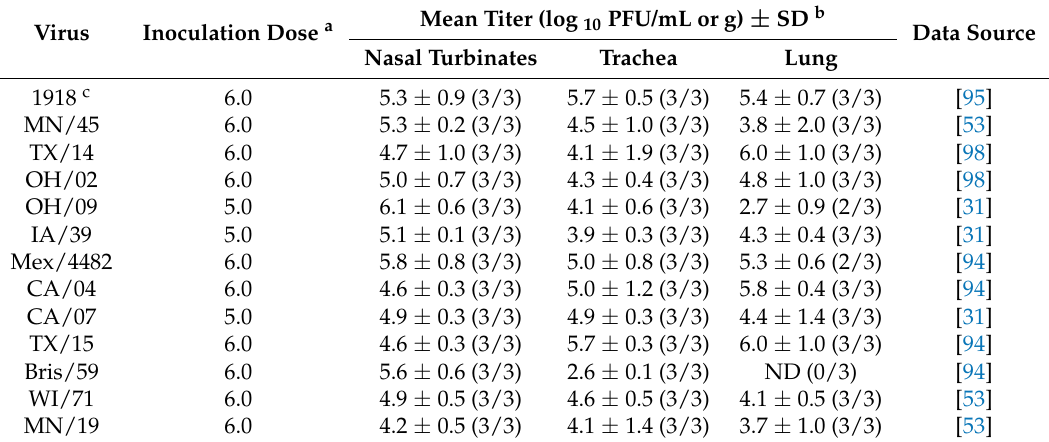
Table 5. Influenza virus detection in ferret respiratory tract